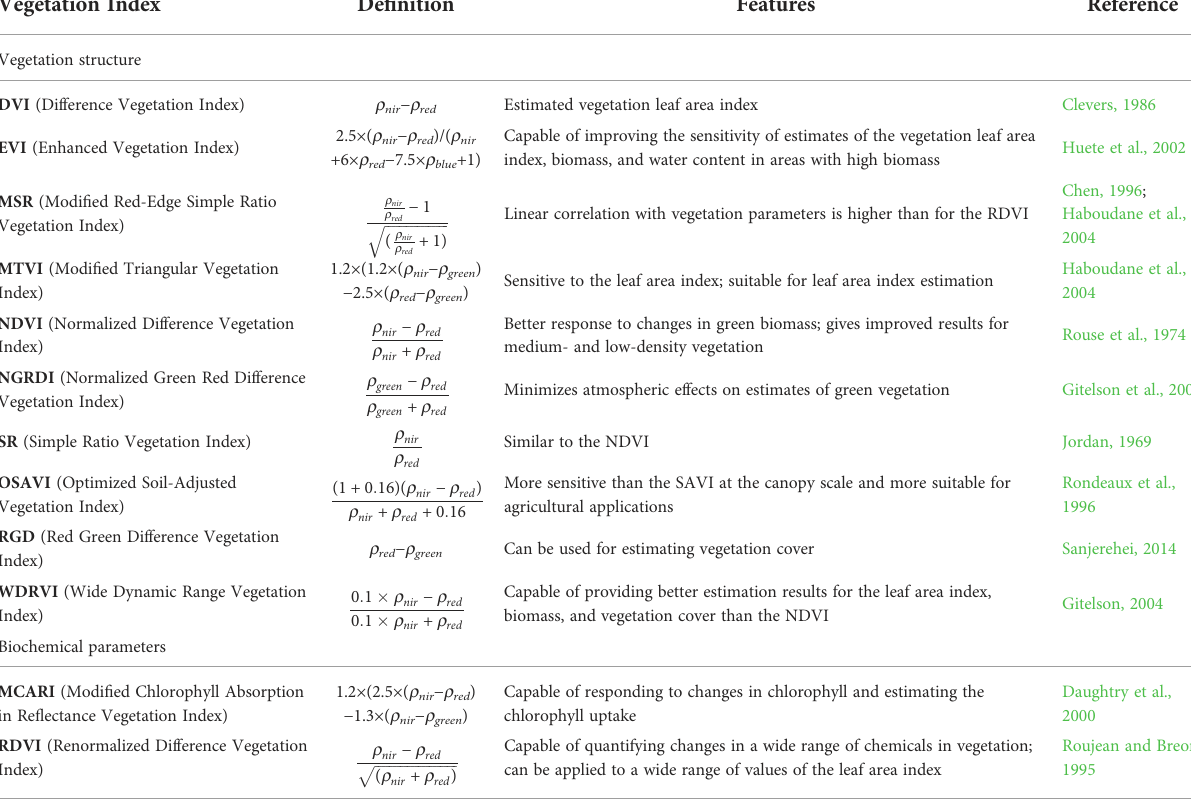
TABLE 2 Summary of vegetation indexes selected for use in this